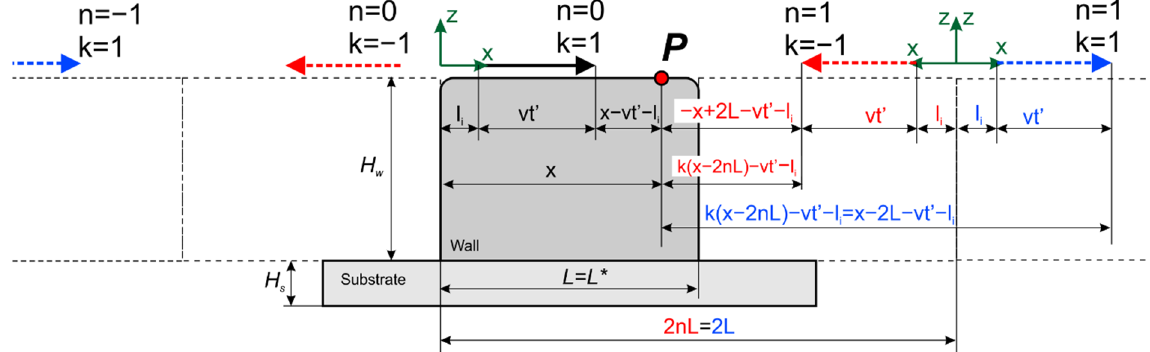
Figure 2. Scheme of introducing imaginary sources to take into account the limited size of the wall in length or width.